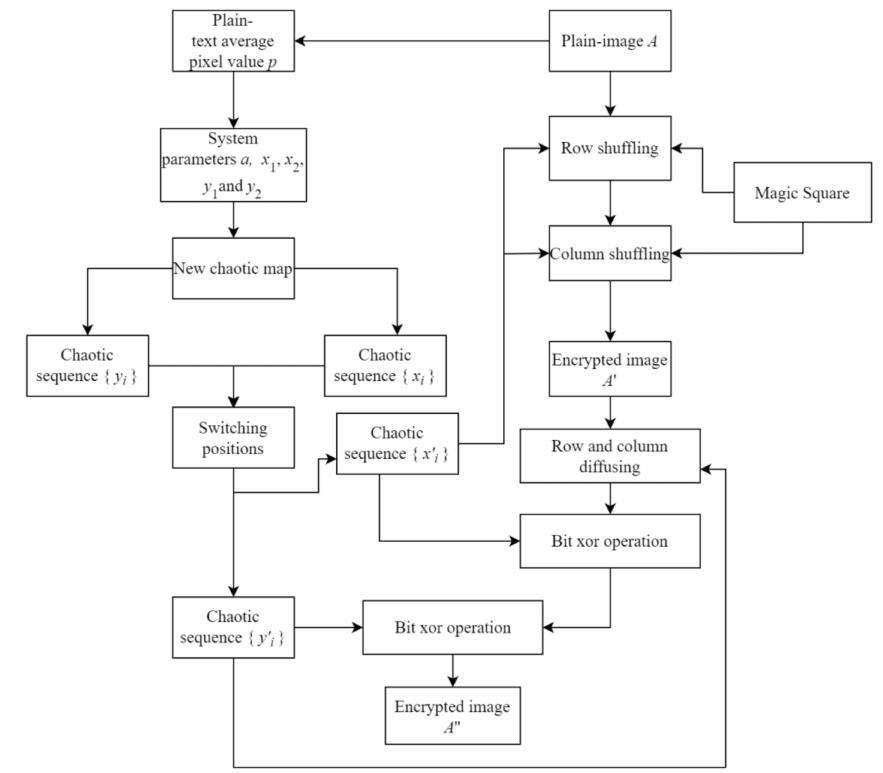
Figure 12. The flowchart of the image encryption